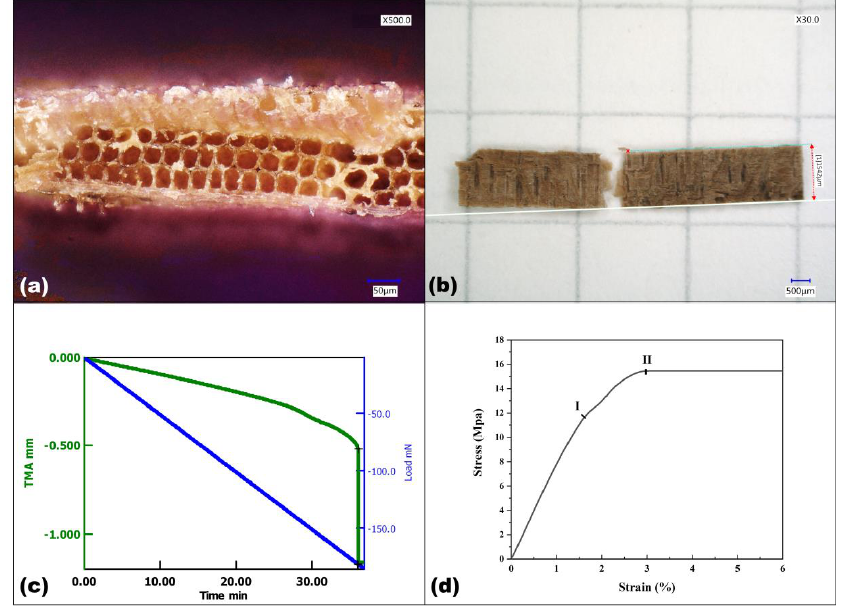
Figure 3. Bending test of archaeological wood with TMA (taking a sample of N1 as an example): ( a ) Failure morphology; ( b ) Failure position; ( c ) Load-time and displacement-time test curves. Negative values represented the direction of load and displacement was downward; ( d ) Stress-strain